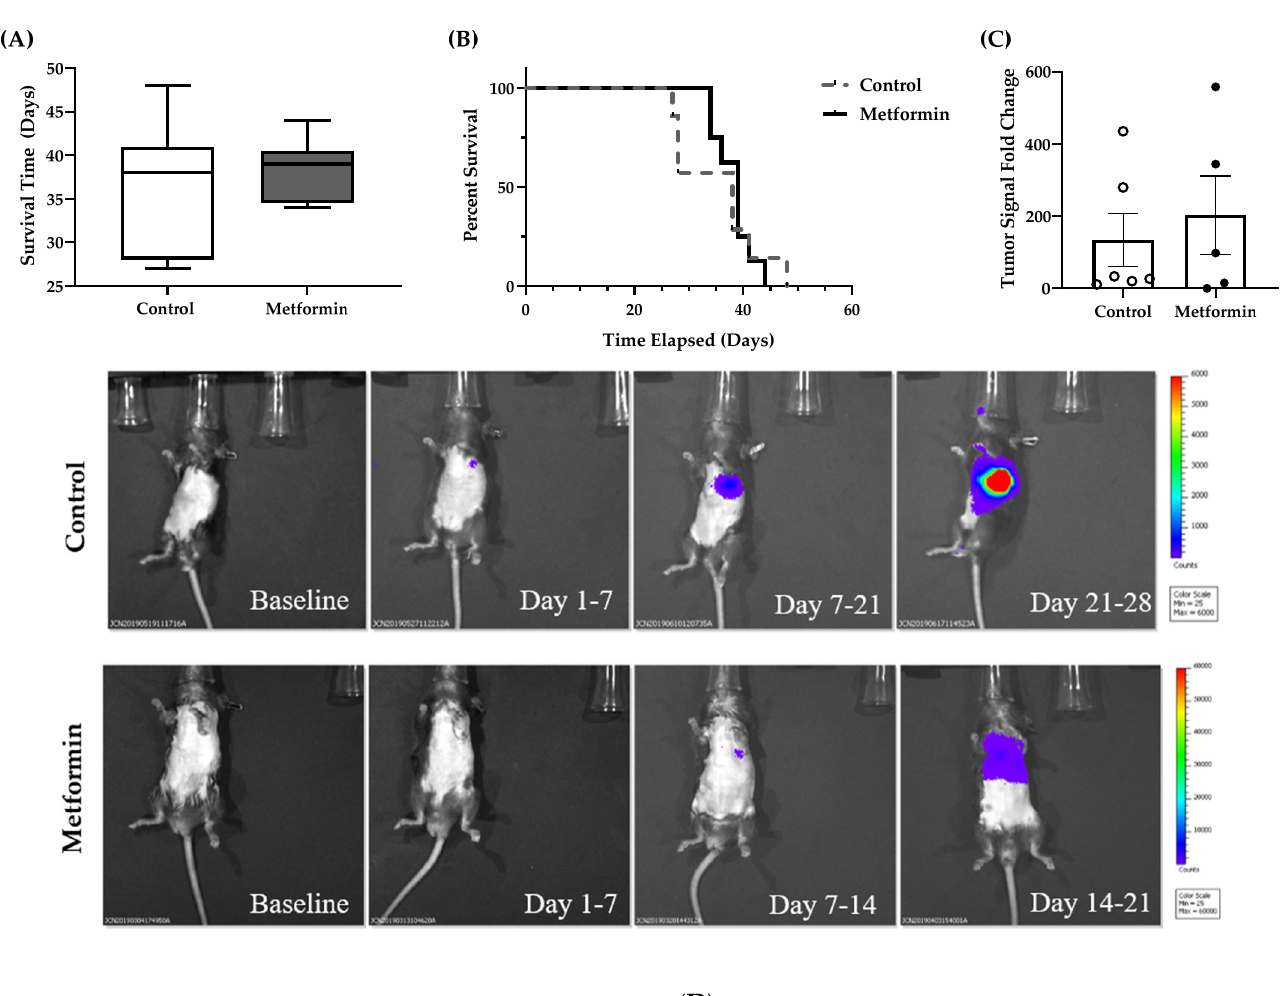
Figure 5. Survival time, tumor burden, and non-small-cell lung tumor growth in C57BL/6J male and female mice following orthotopic LL/2 non-small lung cancer cell implantation. ( A ) Survival duration (days) between control and metformin- (250 mg/kg) treated mice with a detectable bioluminescent signal. Data were analyzed with a Welch’s t -test. ( B ) Percent survival of both control and metformin- (250 mg/kg) treated mice following detection of a bioluminescent signal. Data were analyzed with a Log-rank test. Control, n = 7; metformin, n = 8. ( C ) NSCLC tumor burden fold change between control and metformin- (250 mg/kg) treated mice with a detectable bioluminescent signal. Mice with a saturated signal were removed from analyses. Data were analyzed with a Welch’s t -test. Control, n = 6; metformin, n = 5. Data shown as mean ± SEM. ( D ) Male and female C57BL/6J mice orthotopically administered 1000 Lewis lung carcinoma cells harboring luciferase reporter expression. Bioluminescent signals were tracked throughout the duration of the study via an in vivo imaging system. Once a bioluminescent signal was detected, vehicle or metformin treatment (250 mg/kg, 2× weekly, in- traperitoneal injection) began. Top row: Control C57BL/6J female mouse; Bottom row: metformin-treated C57BL/6J male mouse. Scale represents increased tumor burden as signal intensity increases from blue to red. 3.5. NSCLC Tumor Gene Expression No significant differences were detected in gene expression from NSCLC tumors col- lected from C57BL/6J mice (Unpaired Student’s t -tests, p > 0.05). p27, CDK4, F480, IL-6 or Hes1 gene expression were similar between tumors collected from control and metformin- treated mice (p27, p = 0.639; CDK4, p = 0.973; F480, p = 0.488; IL-6, p = 0.203; Hes1, p = 0.118) (Figure 6). However, Hes1 expression showed a modestly significant effect for sex when males and females are separated within each treatment group [F(1, 8) = 6.828; p = 0.031].